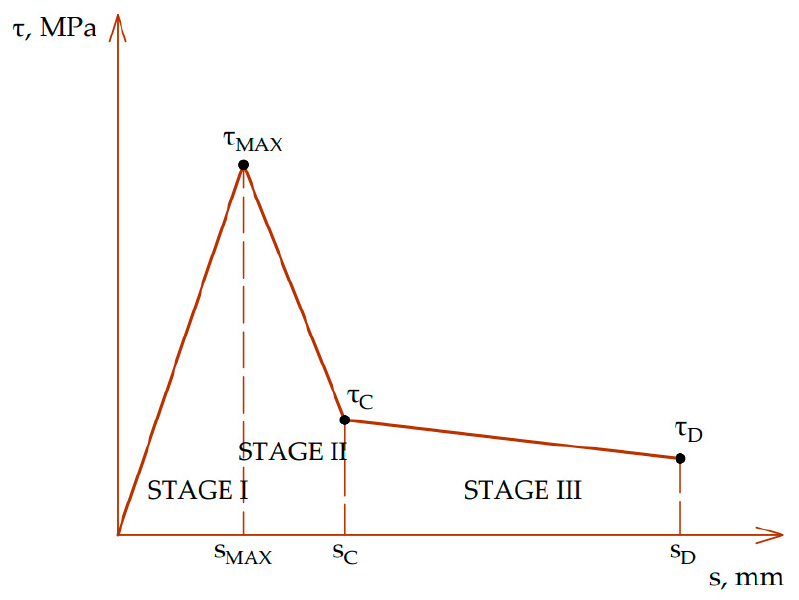
Figure 4. Shear stress—relative slip relationship curve for an interface without connectors.